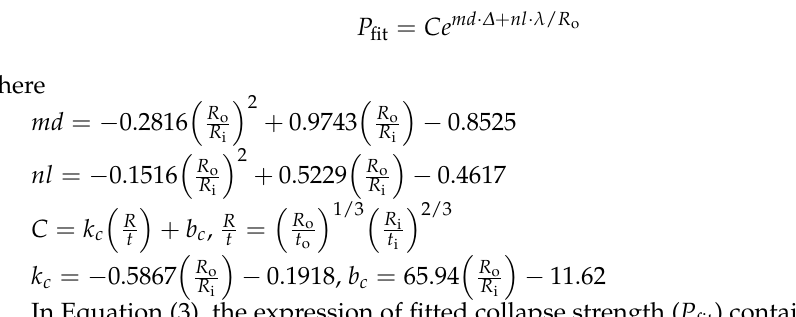
Figure 6. Relationship between collapse strength and ovality length of case series of ‘313 de ’.